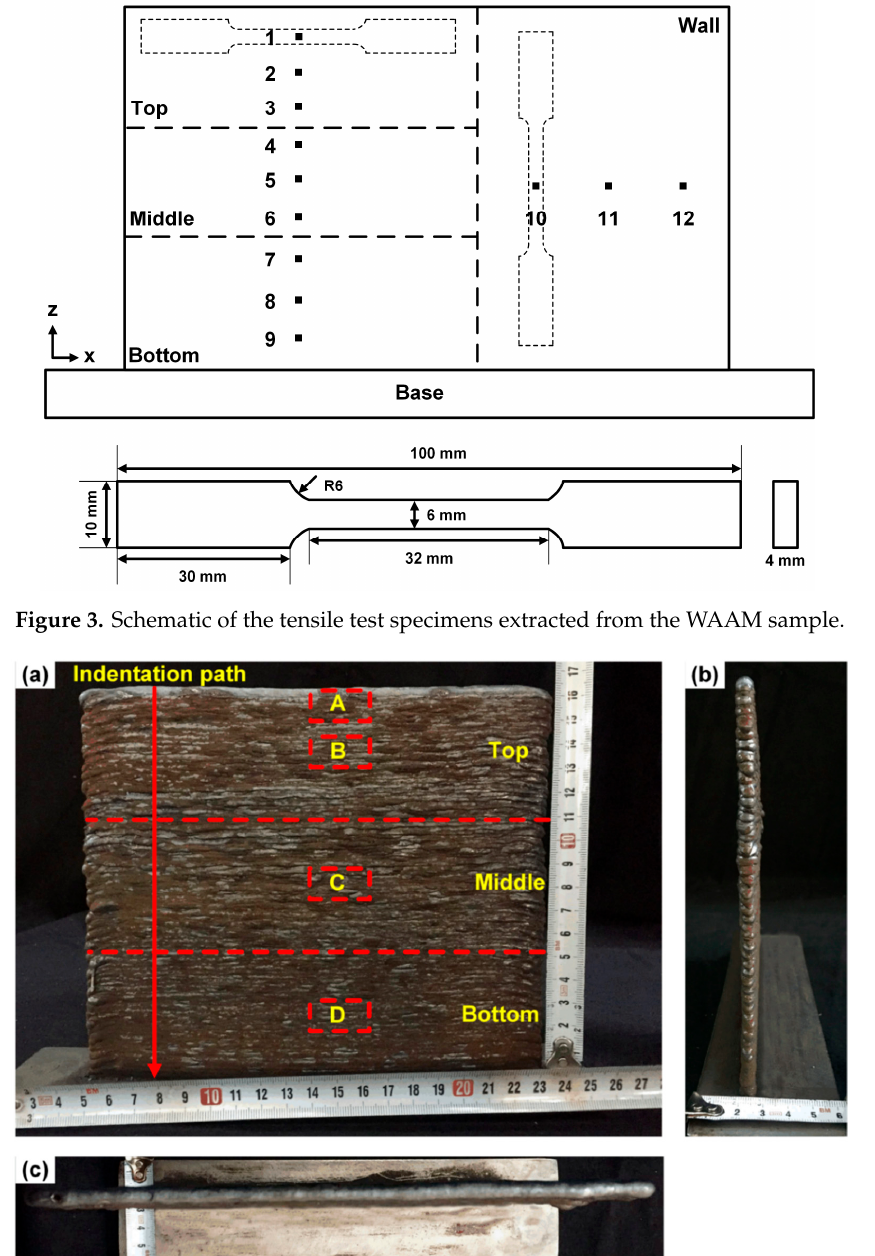
Figure 5. The local cross section at the top region of the wall (under the deposition parameters listed in Table 2). 3.2. Microstructure Evolution during WAAM Deposition The microstructure was investigated at different locations within the WAAM deposited wall (as indicated in Figure 4). Representative etched cross sections at those locations are presented in Figure 6. The cross section revealed the ferrite (white), pearlite (black island), and bainite (black sheaf) phases.